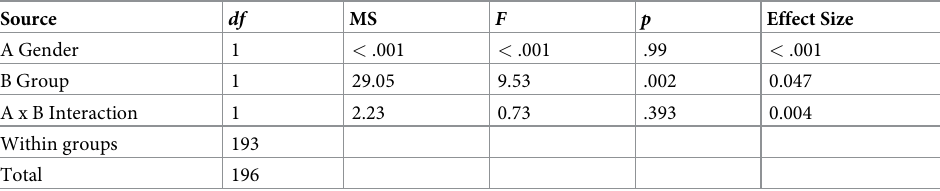
Table 11. ANOVA summary table for depression.